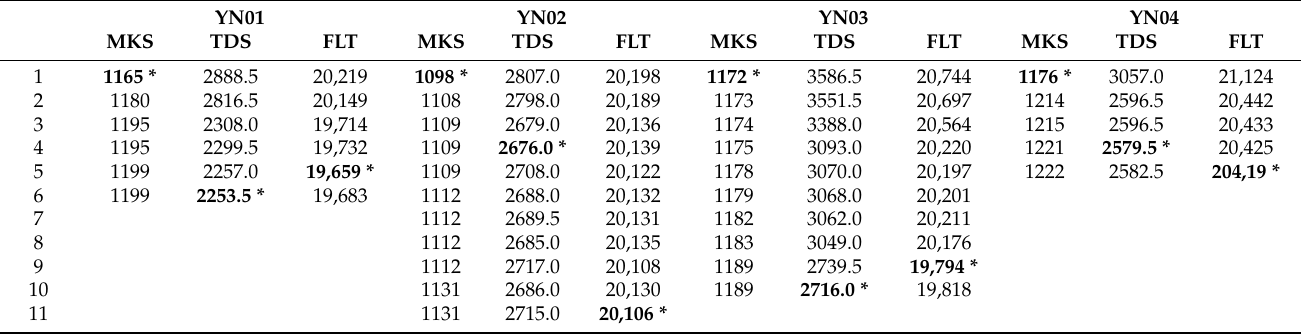
Table A5. Non-dominated solutions obtained by SS/LS for the JSSP instances proposed by [40].